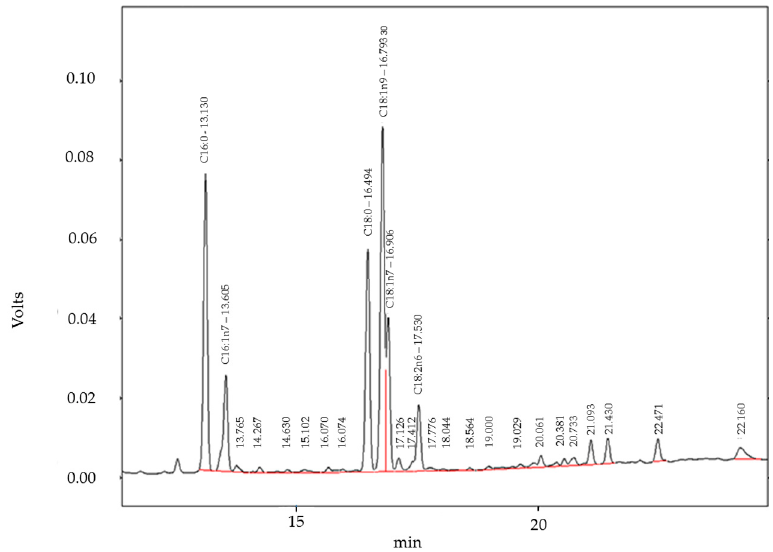
Figure 8. The graph shows a representative GC-FID chromatogram of fatty acids GC-FID chromatogram of fatty acids extracted from the cell lipids. The first two peaks between 13 and 14 min retention time are C16:0 and C16:1n7 acids. The second group between 16 and 17 min are C18:0, C18:1n9, and C18:1n7 (shoulder) acids, and the smaller peak at 17.5 min is C18:2n6 acid. The red line indicates the base for peak integration. indicates the base for peak